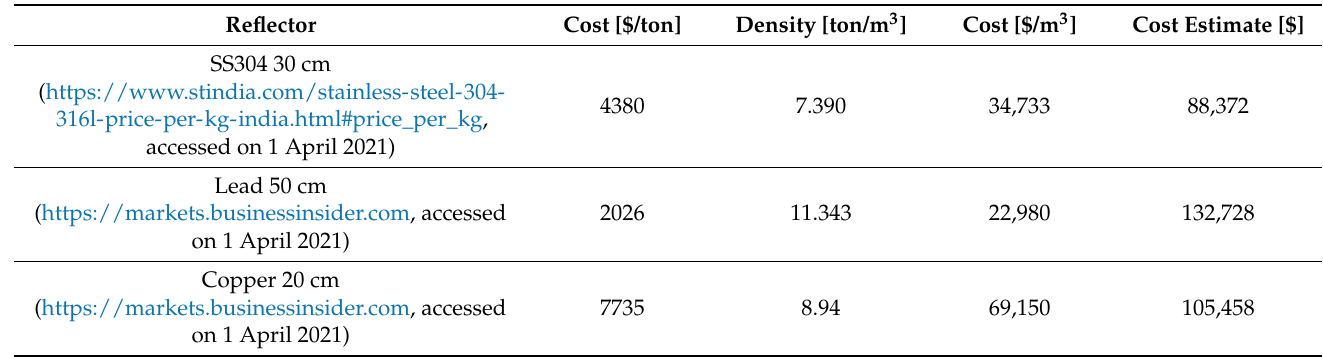
Table 2. Cost comparison for different reflector configurations.